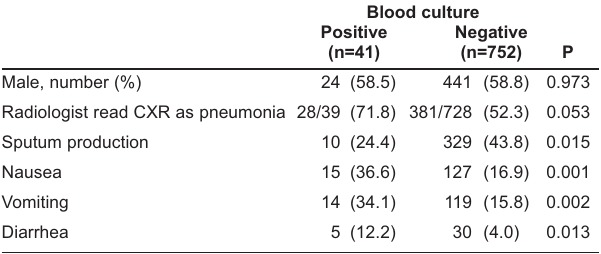
TABLE 3 Comparison of demographic features, symptoms and comorbidities for patients with community-acquired pneumonia who had positive blood cultures with those who had negative blood cultures.